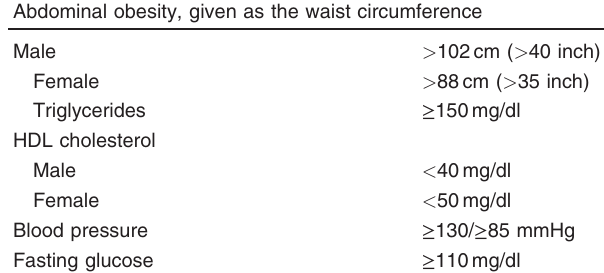
Fasting glucose HDL, high-density lipoprotein. a The presence of three of the five criteria explained above was diagnostic for metabolic